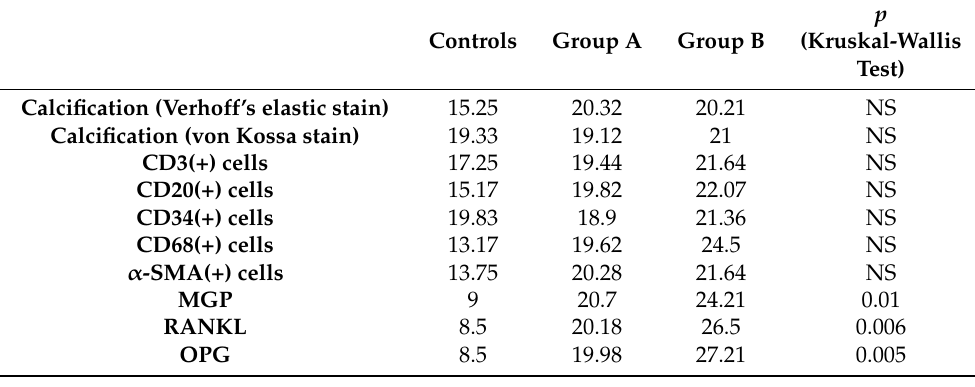
Table 3. Severity of radial artery calcification based on Verhoff’s elastic and von Kossa stain, cellular infiltration and expression calcification regulators on the radial artery. Differences between group patients and controls are expressed by mean ranks and estimated by Kruskal–Wallis test.